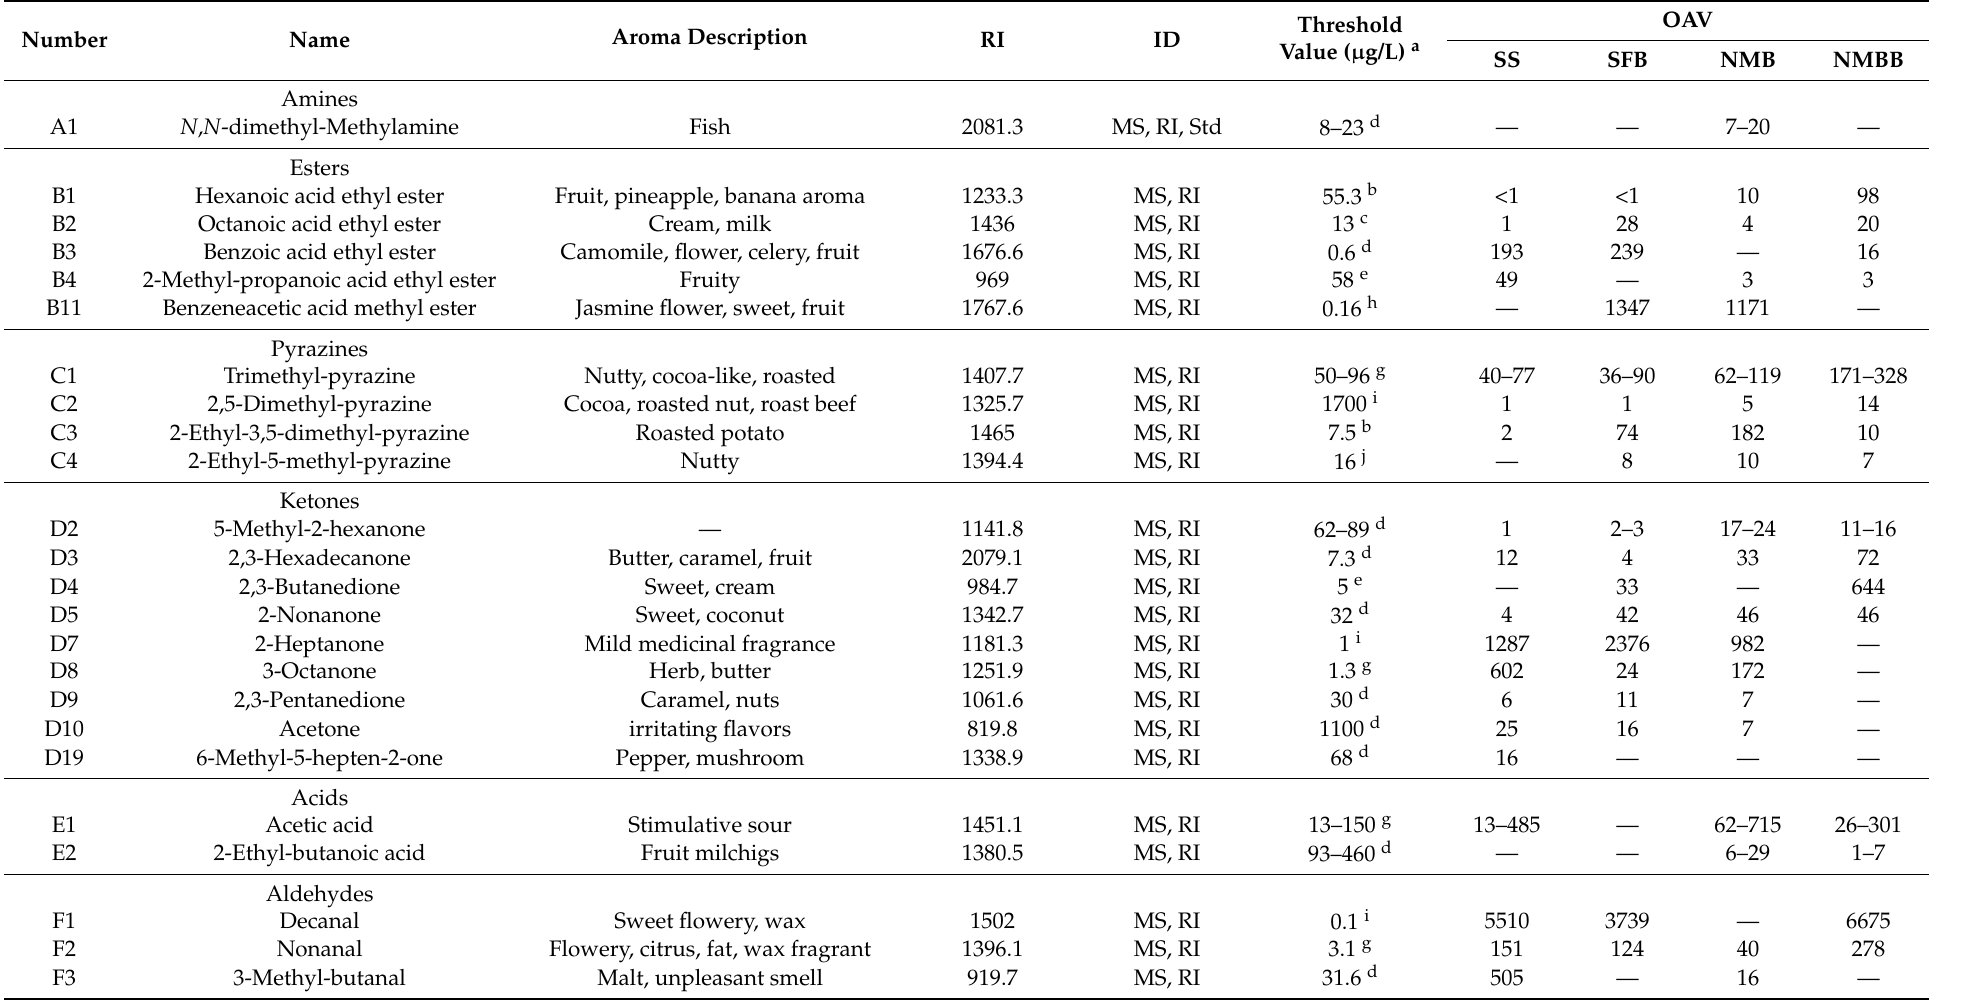
Table 1. OAV of flavor compounds identified in steamed soybean (SS), soybean fermented by BZ25 (SFB), natto made by GUTU09 (NMB), and natto fermented by two-strain